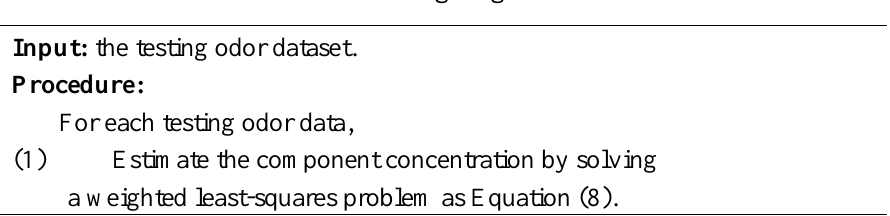
Table 4. The testing stage of